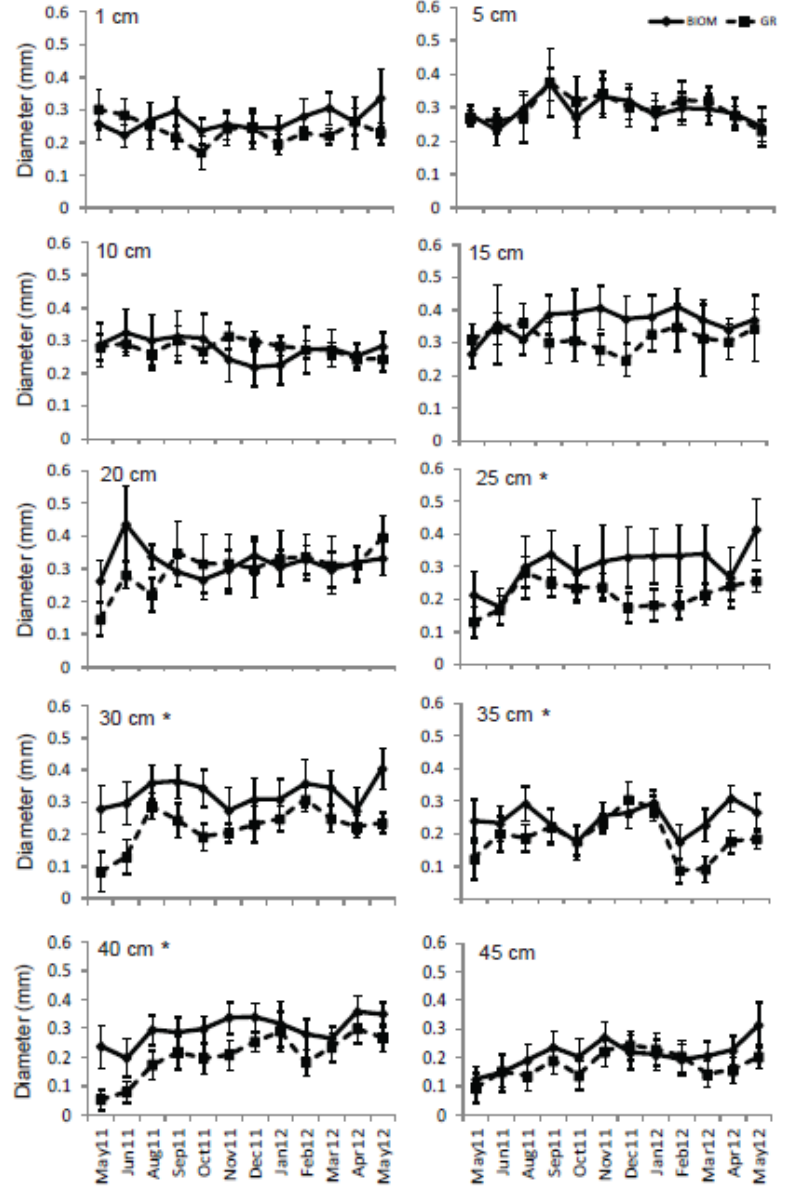
Figure 5. Average root diameter by month and by minirhizotron tube length (5 cm tube length = 3.5 cm vertical soil depth) in soils under established native pastures managed for grazing (GR) and biomass crop exclosures (BIOM). Asterisks after the minirhizotron length represent depths where root diameter is different in soils under grazing and biomass production ( p <